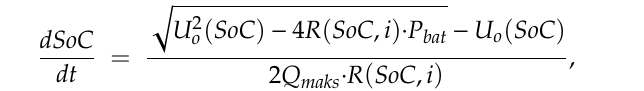
8 of 20 Table 4. Cell and battery parameters.